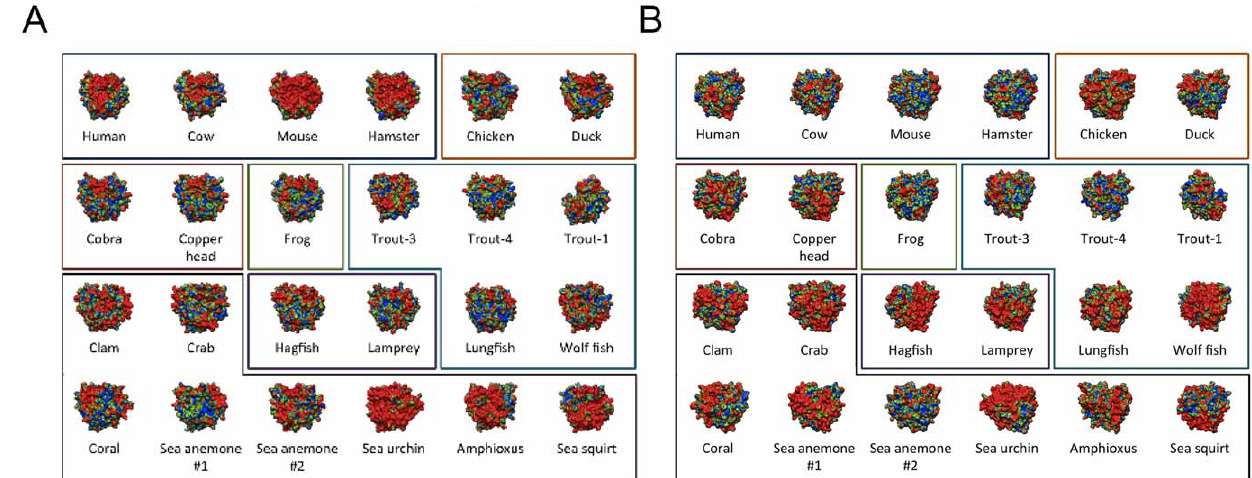
Figure 5. Mutation-based perturbation maps for 24 C3d homologues. The cumulative electrostatic similarity distributions for alanine-scan charge perturbations are projected onto the surface of each respective structure with two rotations: (A) CR2-face and (B) thioester-face. Perturbation map color scheme is: blue – green – red; low to high similarity, corresponding to ESI values of 0.5–0.7–0.9. Colored boxes are used to group homologues from similar species. The box color code is as follows: mammals, dark-blue; birds, orange; reptiles, red; amphibians, green; fish, light- blue; jawless fish, purple; invertebrates, black.